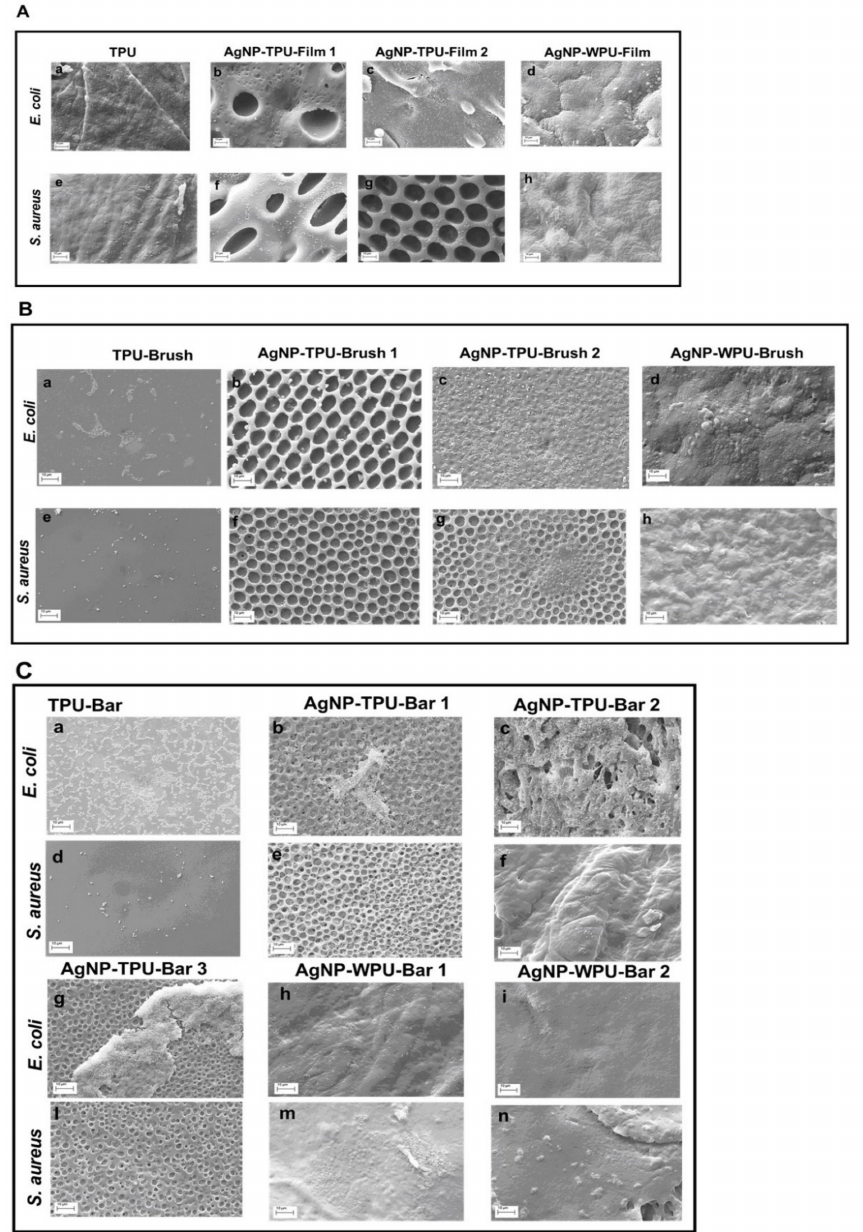
Figure 9. SEM images of bacteria adherent on TPU and WPU polymeric films at 6 kX (scale bar 10 µ m). Panel ( A ): E. coli ( a , d ), S. aureus ( e – h ) on TPU and casted films; panel ( B ): E. coli ( a , d ), S. aureus ( e – h ) on brush films; panel ( C ): E. coli ( a – c ; g – i ), S. aureus ( d – f ; l – n ) on bar coater